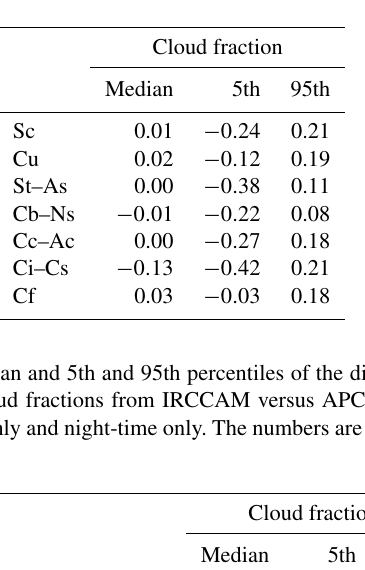
Table 4. Median and 5th and 95th percentiles of the differ- ences in calculated cloud fractions from IRCCAM and Mobotix images for selected cloud classes: stratocumulus (Sc), cumu- lus (Cu), stratus–altostratus (St–As), cumulonimbus–nimbostratus